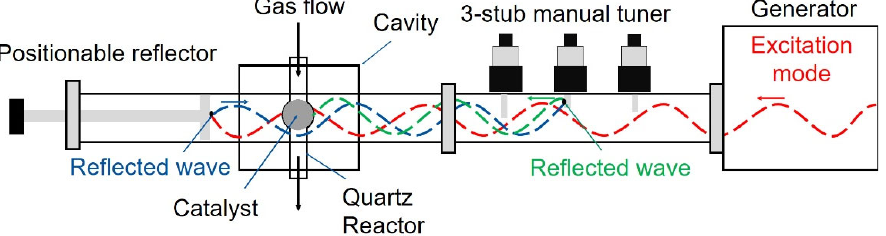
Figure 9. Schematic representation of the monomode MW-catalysis setup. A standing wave (red) originates in the solid-state generator which is subjected to multiple reflections first at the manually positionable reflector (blue) and again at the 3-stub manual tuner (green). By this manual optimization process the MW-power directed towards the sample is maximized, while the power reflected back to the generator is minimized.